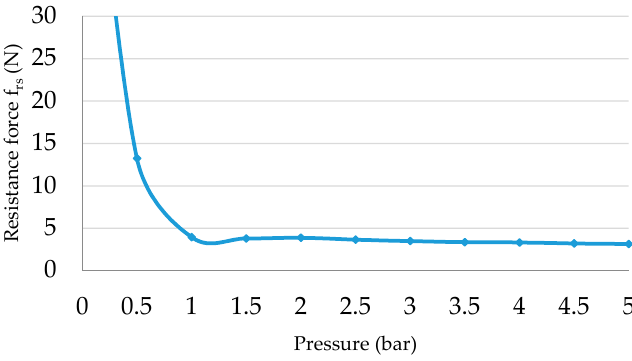
Figure 7. The resistance force of the rubber tube against air.